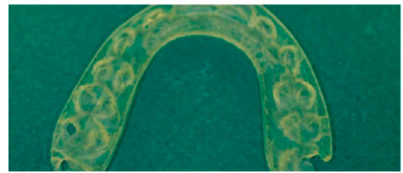
Figure 6. Occlusal plate. Figure 6. Occlusal Figure 5. Osteosynthesis plate for the upper jaw.